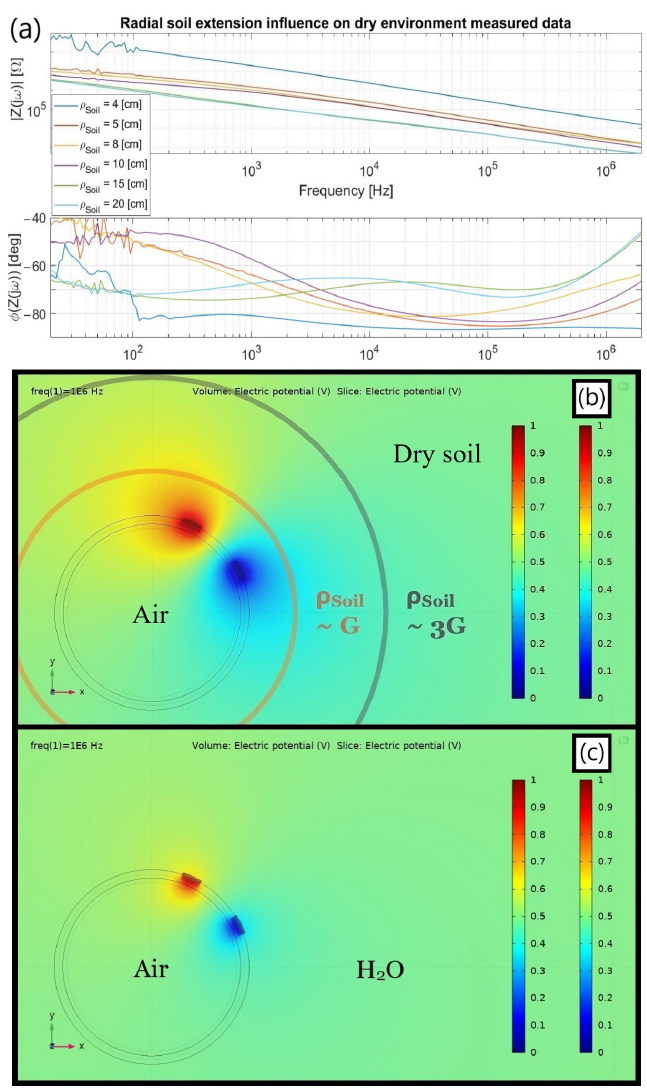
Figure 9. ( a ) Z Soil (j ω ) spectra for an electrode pair with (G, W) = (5, 2) cm on a pipe filled with air when facing variable ground heights; ( b ) F.E.M simulation for the electric field dispersion at 1 MHz along the xy plane using a soil medium outside, with σ Air = 0 μ S/cm and ε R,Air = 1 whereas σ Soil = 100 μ S/cm and ε R,Soil = 10. ( c ) Same as ( b ) with water surrounding ( σ H2O = 1000 μ S/cm and ε R , H2O = 80).